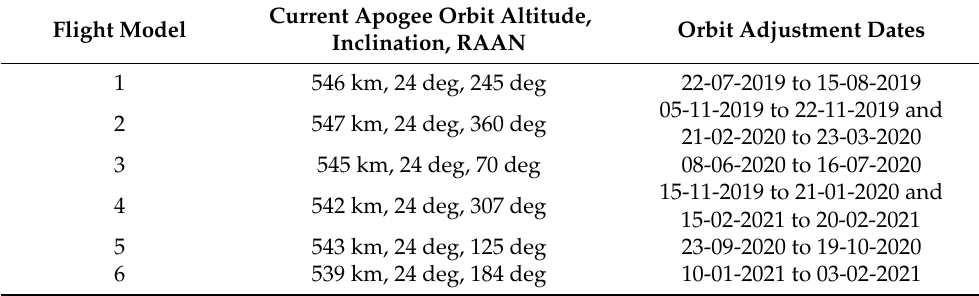
Table 1. Current satellite orbit information and adjustment dates (payloads